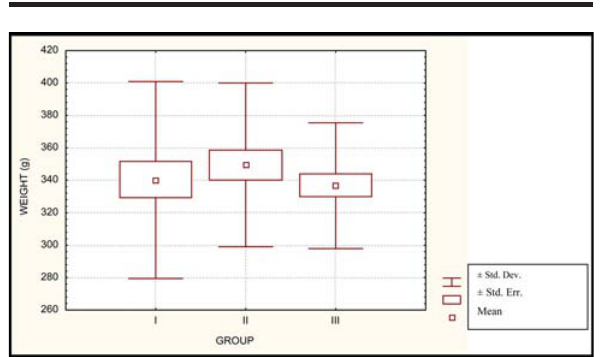
FIGURE 8 - Distribution of the animals by group, with maximum, minimum and medium weights in pre- surgery, and the standard deviation